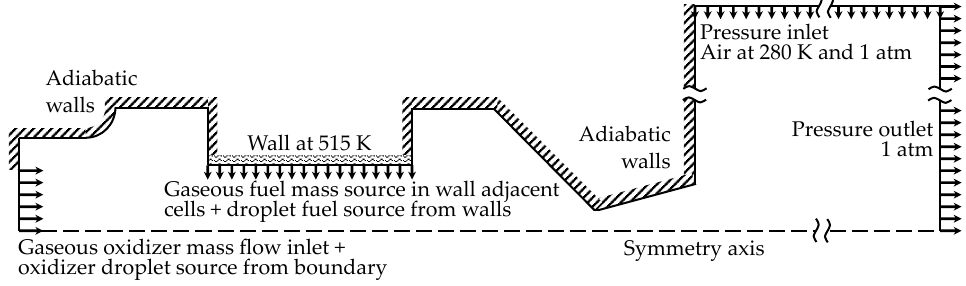
Figure 9. Computational domain with an overview of its boundaries.